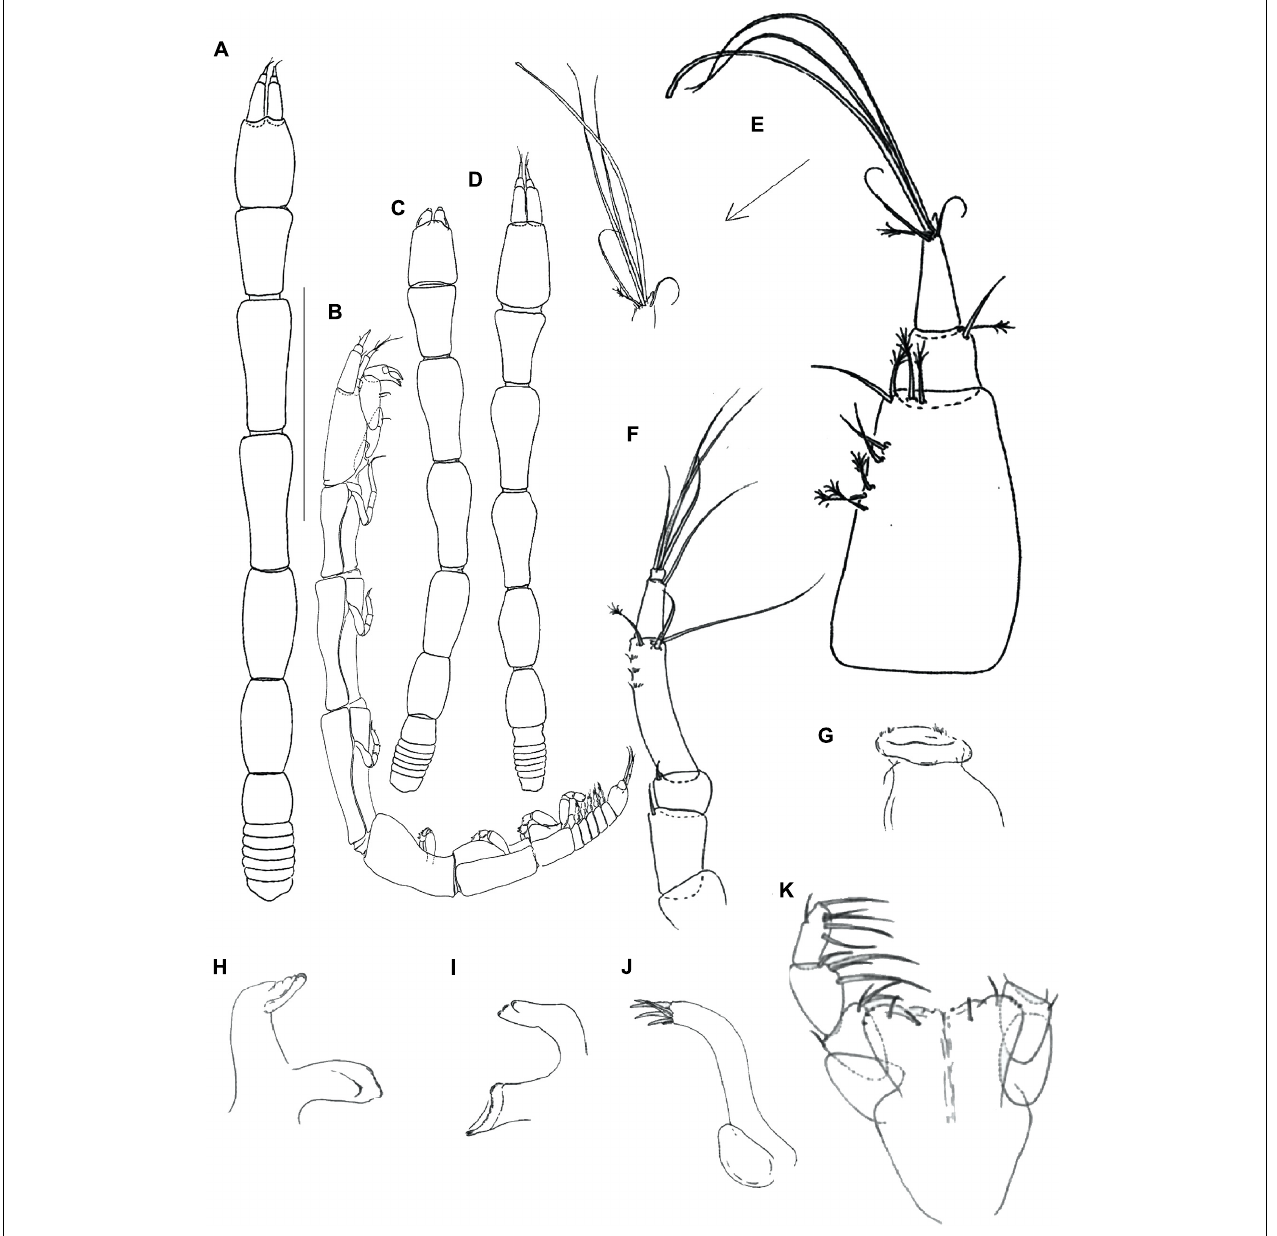
FIGURE 6 | Hamatipeda mojito n. sp. (MCZ 49272) (A,B) neuter; (C,D) manca-2 and 3, respectively; (E) antennule; (F) antenna; (G) labrum; (H,I) mandible left and right, respectively; (J) maxillule endite and maxilla; (K) maxilliped. Scale: panels (A,B) = 1 mm, panels (C–K) = 0.1